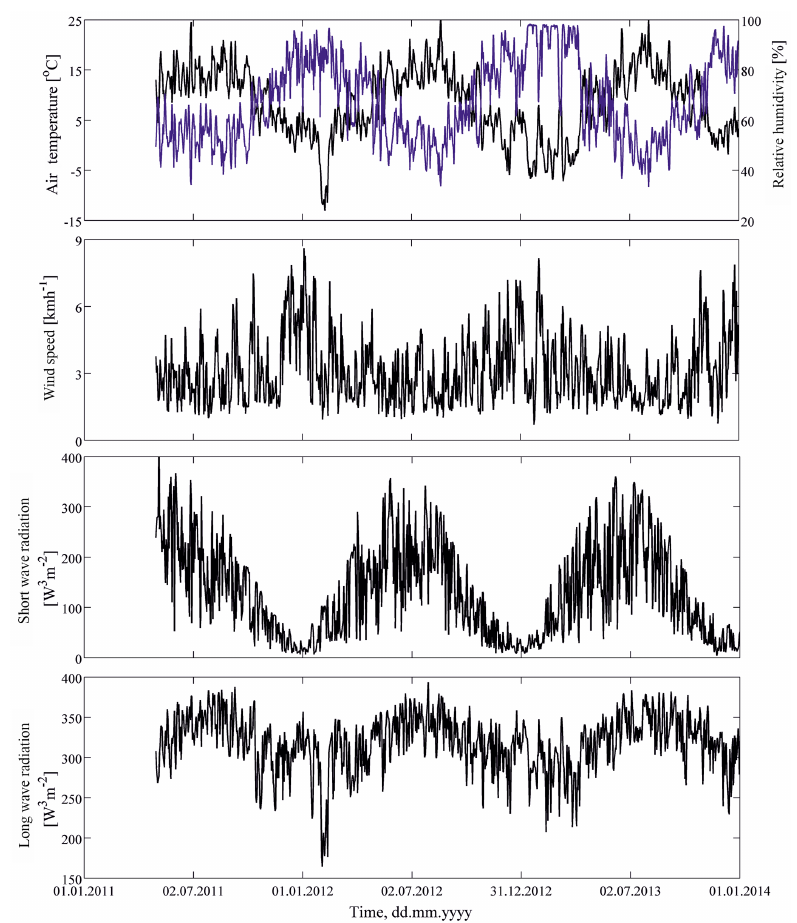
Figure 7. Daily averages of air temperature, relative humidity, wind speed, and incoming short- and long-wave radiation measured at the eddy covariance station from 1 May 2011 to 31 December